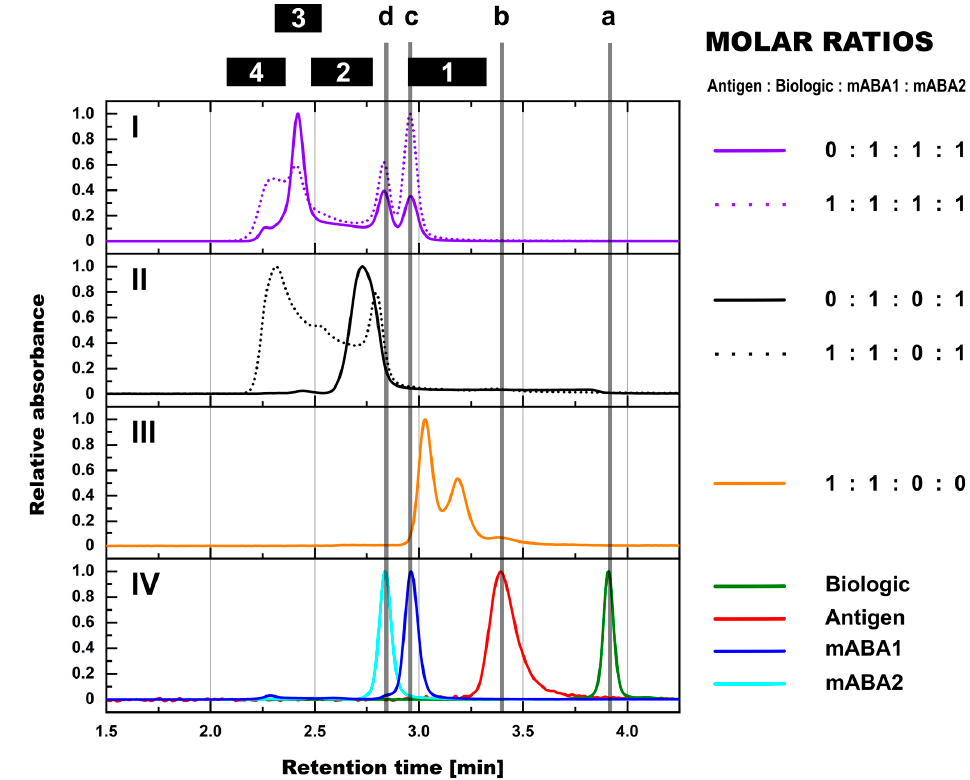
Figure 1. SEC-UV assessment of complex formation between biologic, antigen, and mABAs in PBS matrix. SEC profiles from equimolar mixtures are shown for biologic:mABA1:mABA2 ± antigen on panel ( I ), for biologic:mABA1 ± antigen on panel ( II ), and for antigen:biologic on panel ( III ). Panel ( IV ) shows controls, i.e., biologic in green, antigen in red, mABA1 in blue, and mABA2 in cyan. Marker: (a) free biologic, (b) free antigen, (c) free mABA1, (d) free mABA2, (1) antigen:biologic complexes, (2) immune complexes with a single ABA incorporated, (3) immune complexes with two incorporated ABAs, (4) immune complexes with more than two incorporated